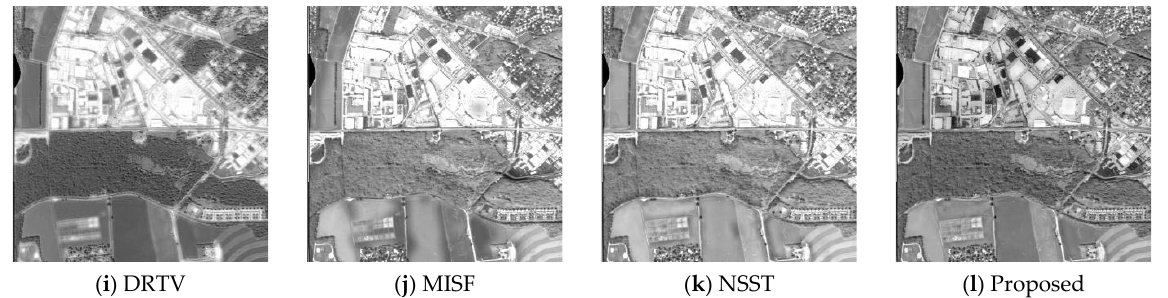
Figure 6. Fusion results of the third group of images. ( a ) Source A, ( b ) Source B, ( c ) GFF, ( d ) IFM, ( e ) DTCWT, ( f ) CVT, ( g ) PC, ( h ) SAIF, ( i ) DRTV, ( j ) MISF, ( k ) NSST, ( l ) proposed method.